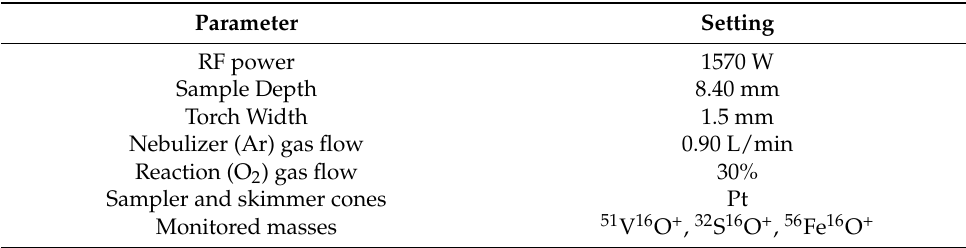
Table 1. ICP-MS/MS optimized operational